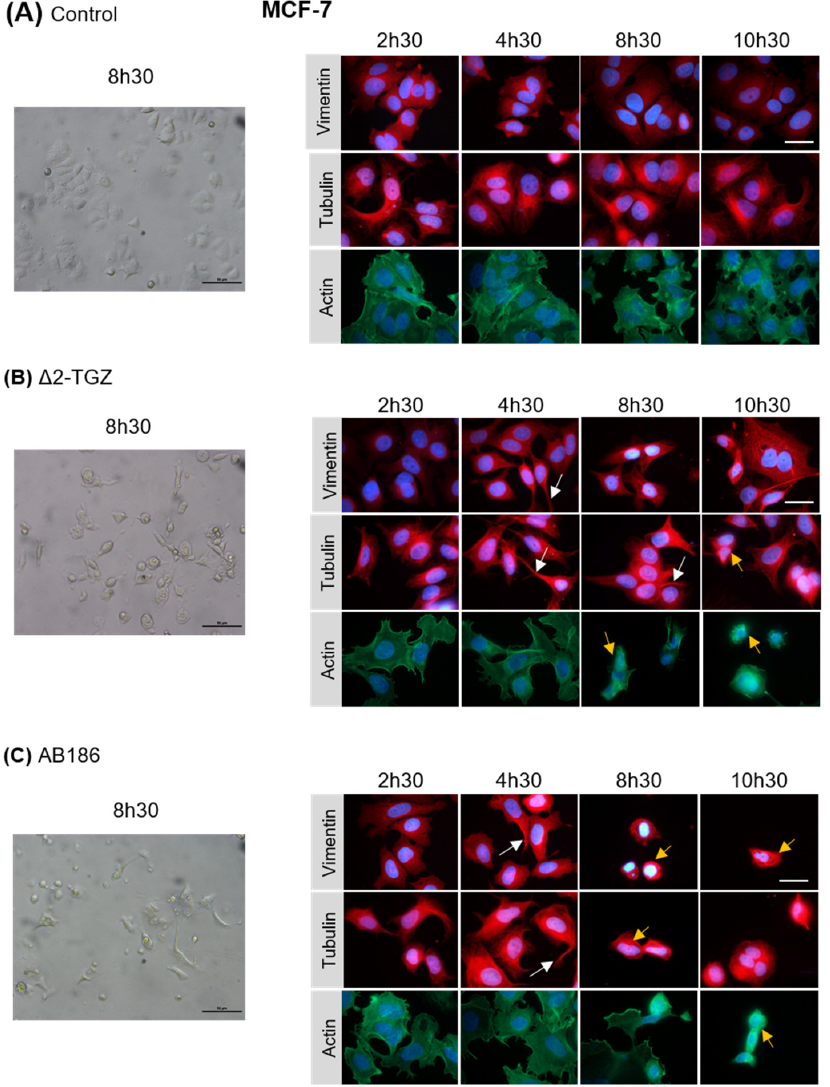
Figure 4. TGZ derivatives alter MCF-7 morphology. MCF-7 cells were treated with DMSO as control ( A ), 25 µM of Δ 2-TGZ ( B ) or 5 µM of AB186 ( C ) during 2 h 30 min, 4 h 30 min, 8 h 30 min, and 10 h 30 min. Then, cells were subjected to immunofluorescence analysis and stained with antibodies against vimentin, α -tubulin, and actin. Cell nuclei were labelled with Hoechst dye. Bright field pictures of control and treated cells are also shown after 8 h 30 min. ∆ 2-TGZ and AB186 led to a disruption of cell–cell contact compared to untreated cells. Elongated cells (white arrows) and some shrunken cells (yellow arrows) were observed. Bar represent 50 µ